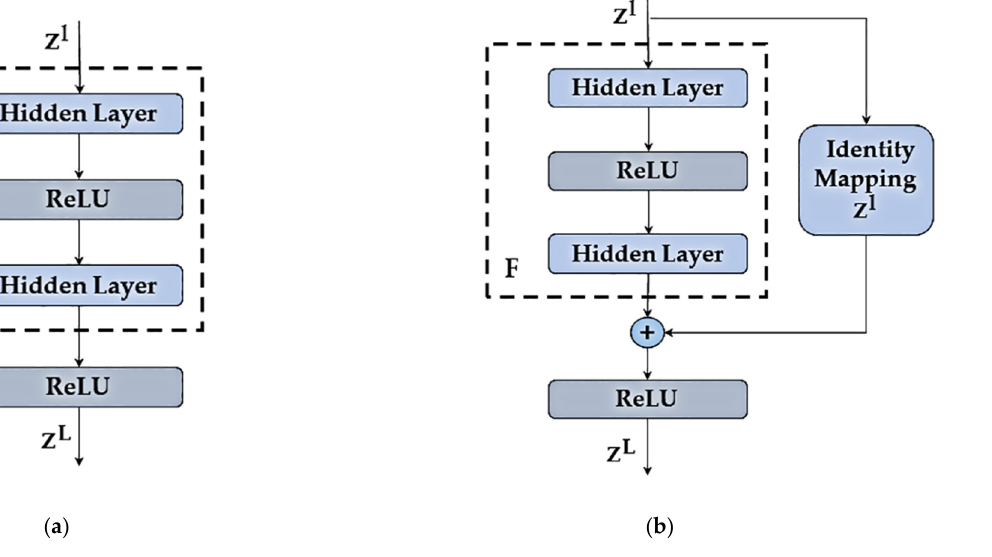
Figure 1. Connection mode of a neural network: ( a ) ordinary connected structure; ( b ) residual connected structure.